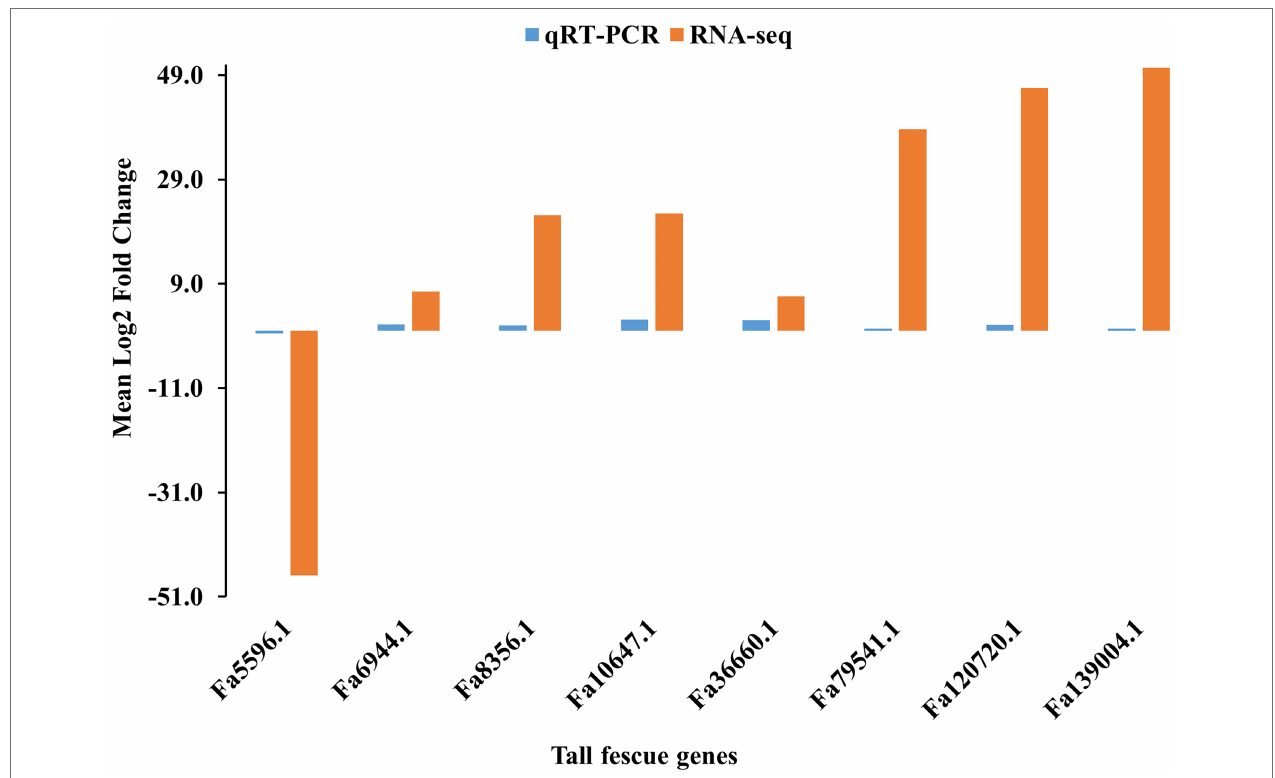
FIGURE 6 | Validation of RNA-seq data obtained from pseudostem of E+ and E − tall fescue collected at morning freezing temperatures through qRT-PCR analysis. The gene expression pattern was shown in x -axis and the log2 fold change value was shown in y